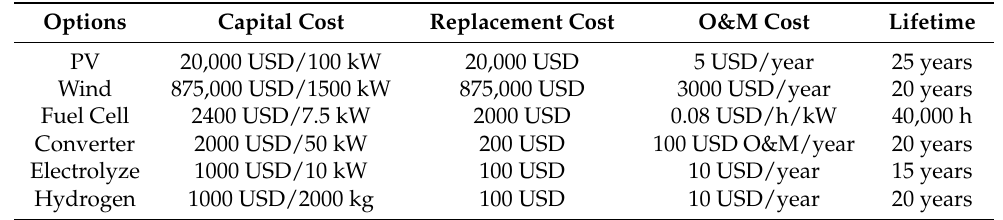
Table 4. Input data on option costs.